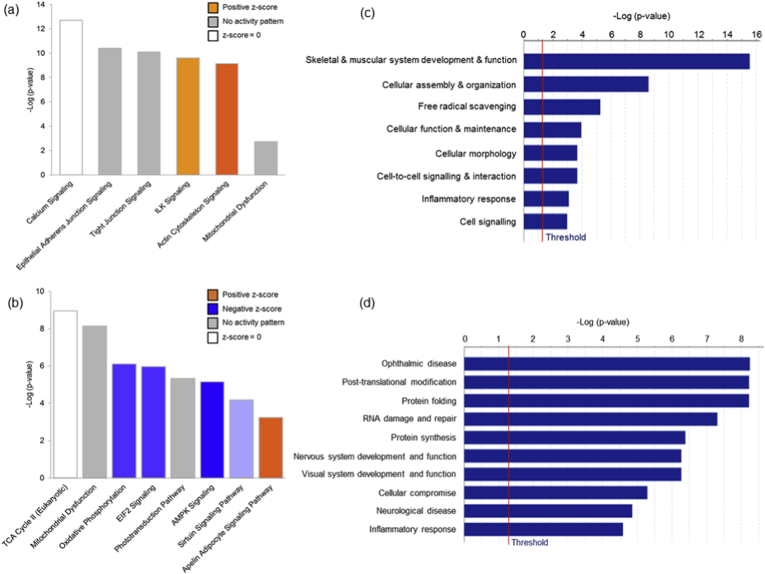
Top significantly affected canonical pathways and diseases and biological functions. Bar charts depict the significantly (p < 0.001) enriched canonical pathways determined by p-value overlap between the proteins identified in our datasets and the molecules in the respective pathways, implicated in the (a) ophthalmic artery and (b) retina following Ang II treatment. Overall z-scores are represented by the colour orange, which indicates activation and blue indicates inhibition of the signalling pathways; grey indicates indeterminable activity pattern. Negative log10-transformed p-values of the top significant diseases and biological functions of the differentially expressed proteins are represented by horizontal bar charts for (c) ophthalmic artery and (d) retina. (For interpretation of the references to colour in this figure legend, the reader is referred to the Web version of this article.)